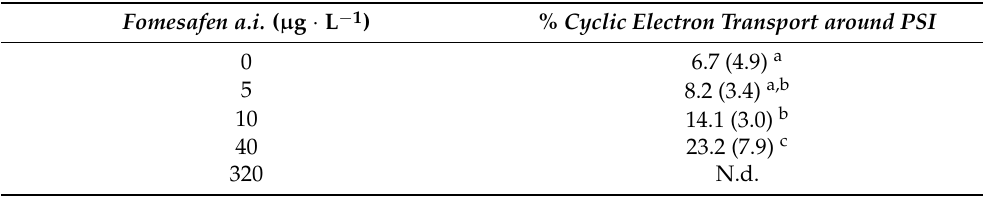
Table 1. Cyclic electron transport for R. subcapitata following 72 h exposure to five concentrations of fomesafen-based herbicide (Reflex ® ; 0, 5, 10, 40 and 320 µ g · L − 1 fomesafen a.i.). N.d. stands for not determined as the cell densities of the cultures were insufficient to obtain a signal at the highest fomesafen-based herbicide concentration. Means ± standard deviation of nine replicates. Means connected by the same letters are not significantly different by the Tukey–Kramer HSD